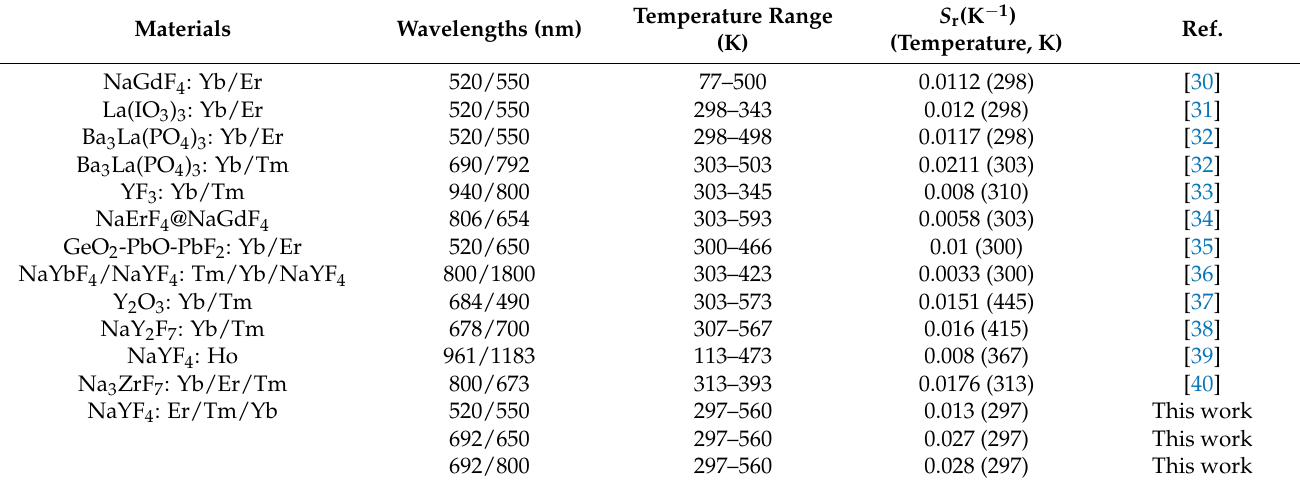
Table 2. Comparison of relative sensing sensitivities in LIR